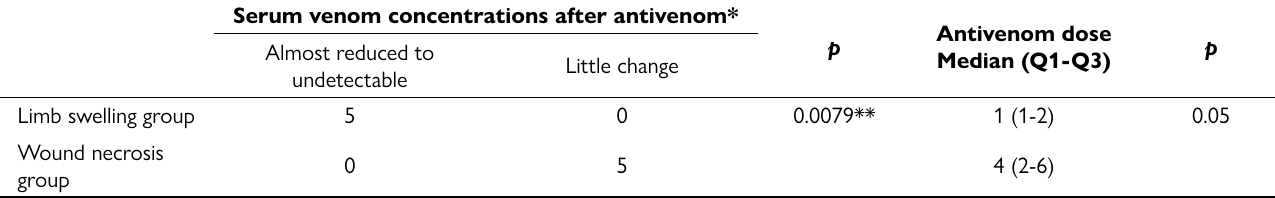
Table 4. Comparison of the changes in serum venom concentrations after use of antivenom and antivenom dosage between limb swelling group and wound necrosis group.